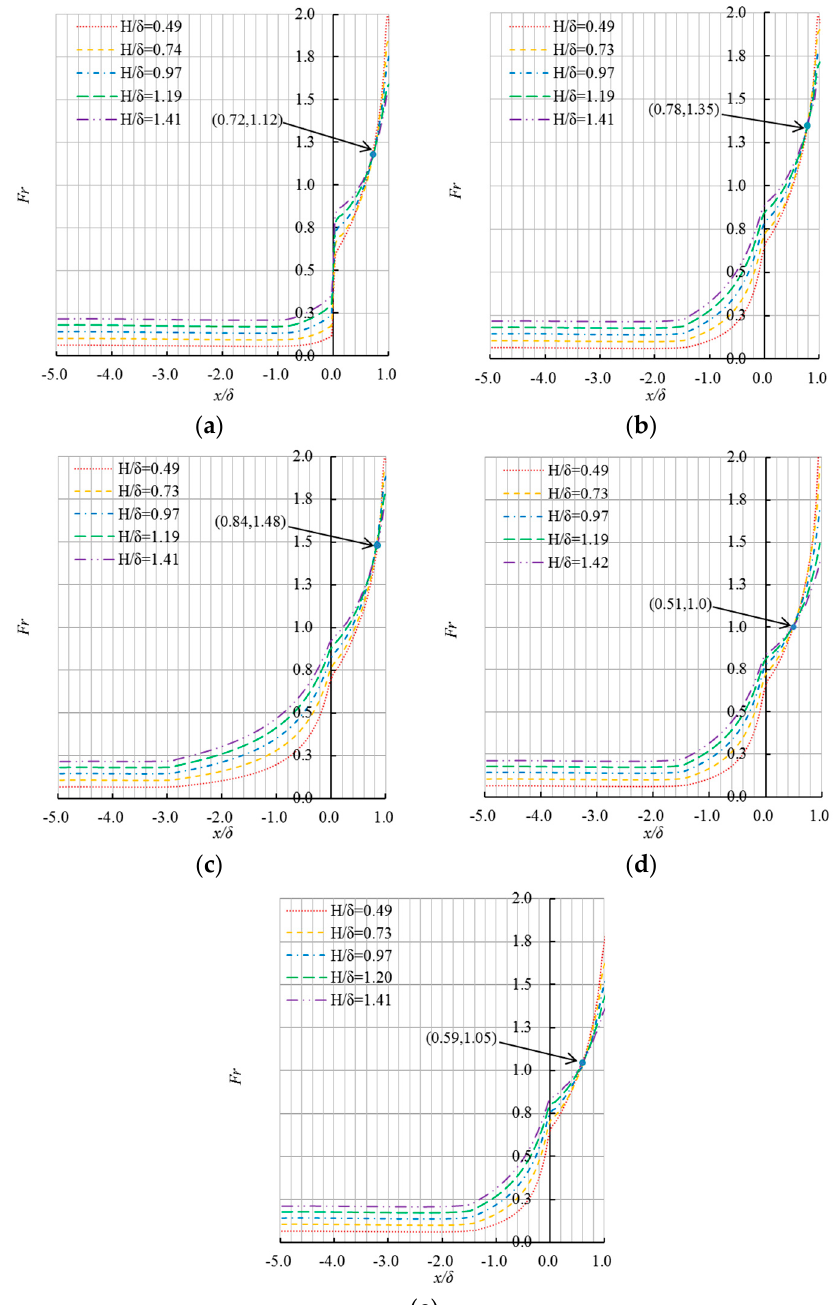
Figure 14. Froude numbers along streamwise direction on different inflow conditions: ( a ) S 1 = 0.0, S 2 = 0.8; ( b ) S 1 = 1.0, S 2 = 0.8; ( c ) S 1 = 2.0, S 2 = 0.8; ( d ) S 1 = 1.0, S 2 = 0.0; ( e ) S 1 = 1.0, S 2 = 2.0.